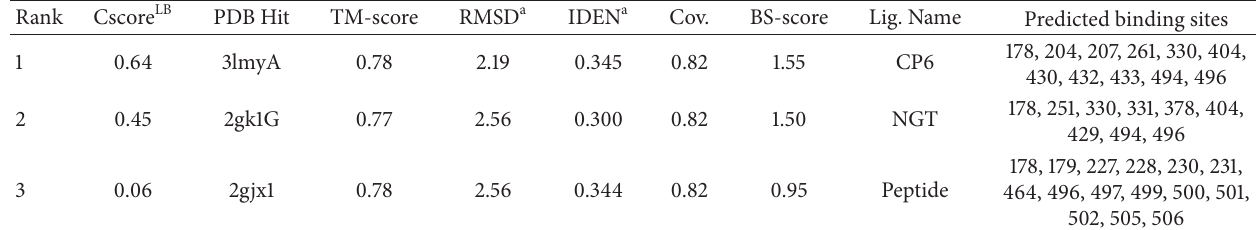
Table 4: Template proteins with similar binding sites searched by COFACTOR.